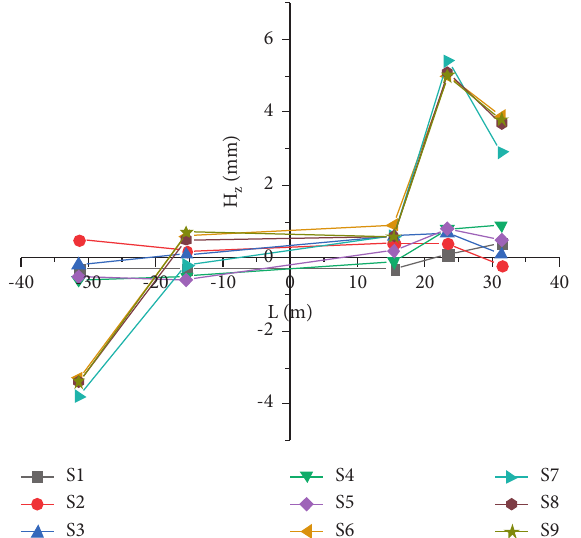
Figure 9: Changes in surface settlement under different working conditions.